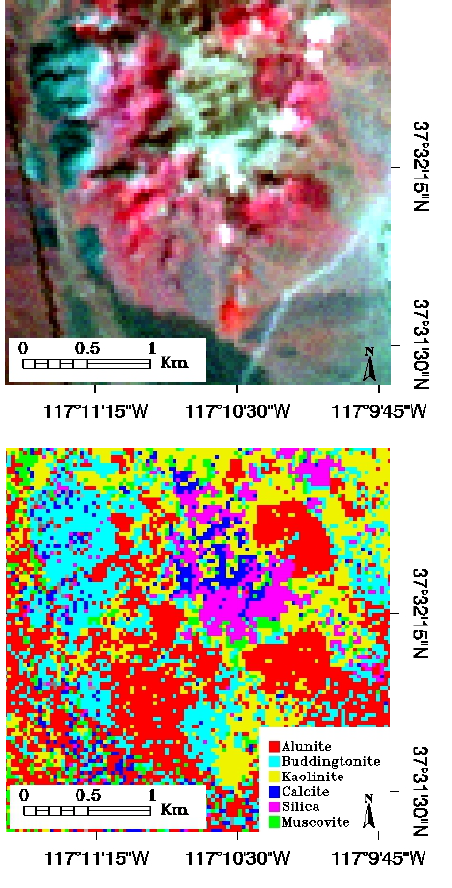
Figure 7. ( Top Left ) Enlarged portion of the ASTER SWIR color composite image at 30 m spatial resolution (SWIR bands 4, 6, 8 or 1.66, 2.21, 2.34 μ m as RGB). ( Top Right ) Simulated Worldview-3 SWIR color composite image at 7.5 m spatial resolution (SWIR bands 3, 6, 8 or 1.65, 2.20, 2.33 μ m as RGB). ( Bottom Left ) Enlarged portion of ASTER SWIR mineral map from Figure 4. ( Bottom Right ) Worldview-3 SWIR mineral map. Note the high level of detail in the Worldview-3 SWIR color composite image compared to the ASTER color image and the corresponding improvement in the Worldview-3 mineral map (a combination of high spectral and spatial